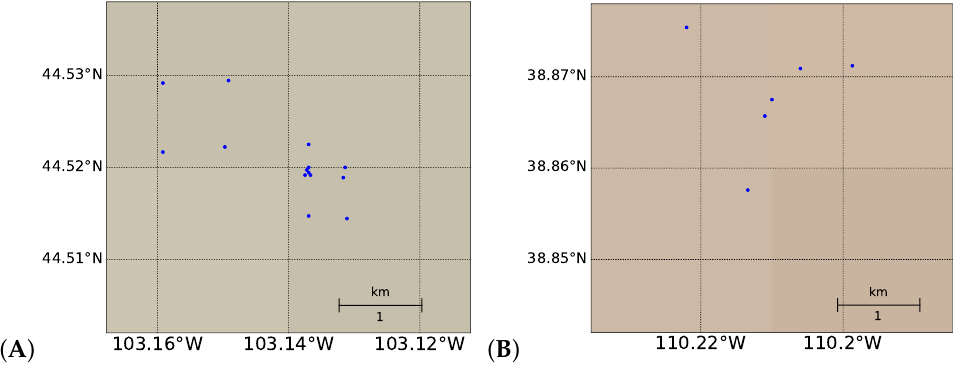
( A ) Figure 3. Cont